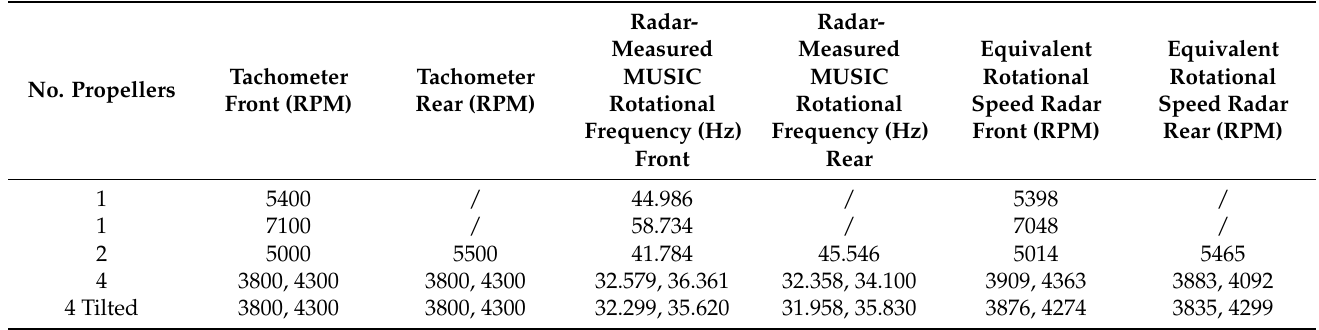
Table A3. Results obtained with a MUSIC signal subspace of one hundred and twenty